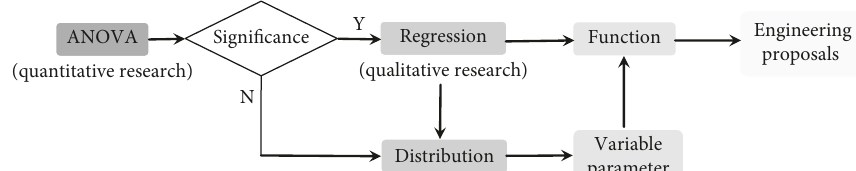
Figure 4: Approach of the statistical analysis.